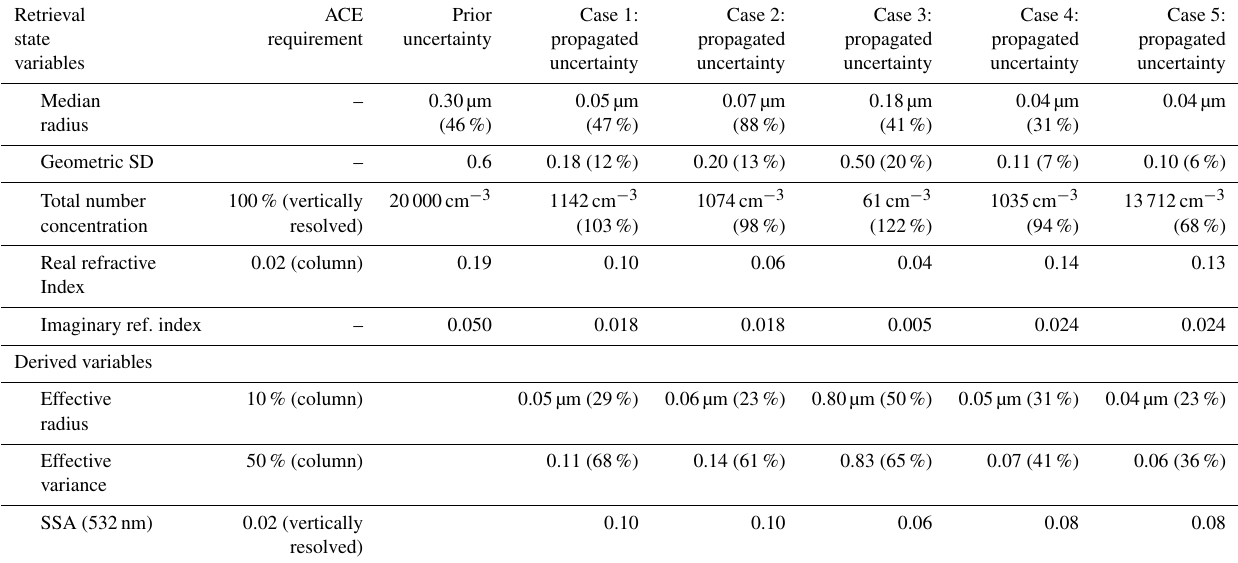
Table 3. Propagated uncertainties (standard deviations) for state variables and selected additional variables derived from the state variables, shown for the reference cases described in Table 1. The uncertainties are shown as absolute value for all variables with relative uncertainty in parenthesis for the size distribution variables. The propagated uncertainties (Eq. 9) depend on assumed measurement errors of 5% for backscatter and 20% for extinction and depend on a priori covariance as described in the text. The assumed a priori uncertainty and the requirements described in the ACE white paper (also 1 standard deviation) are listed for